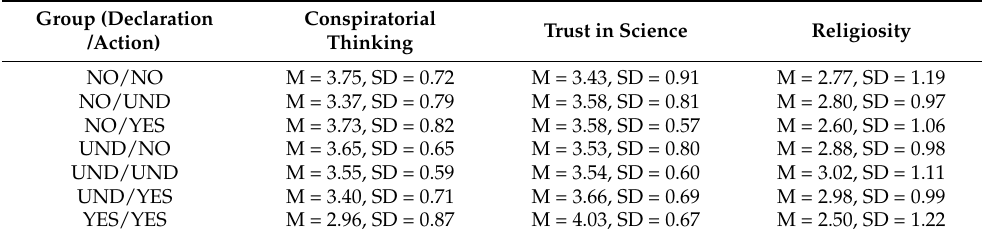
Table 1. Means and standard deviations of individual differences between